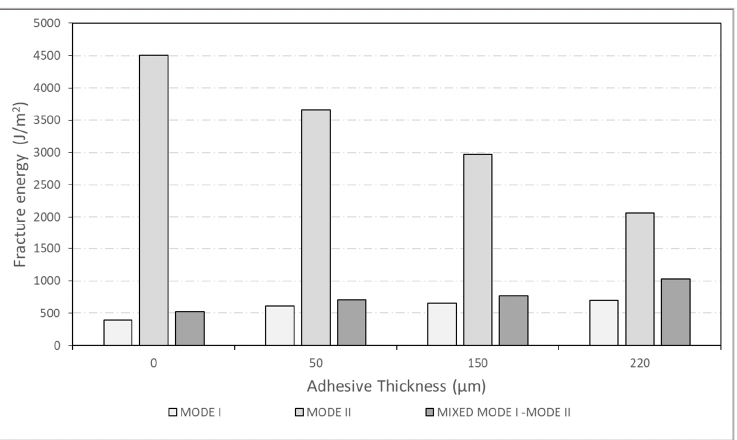
Figure 24. Final interlaminar fracture energy comparison of all batches of GFRP in different modes.